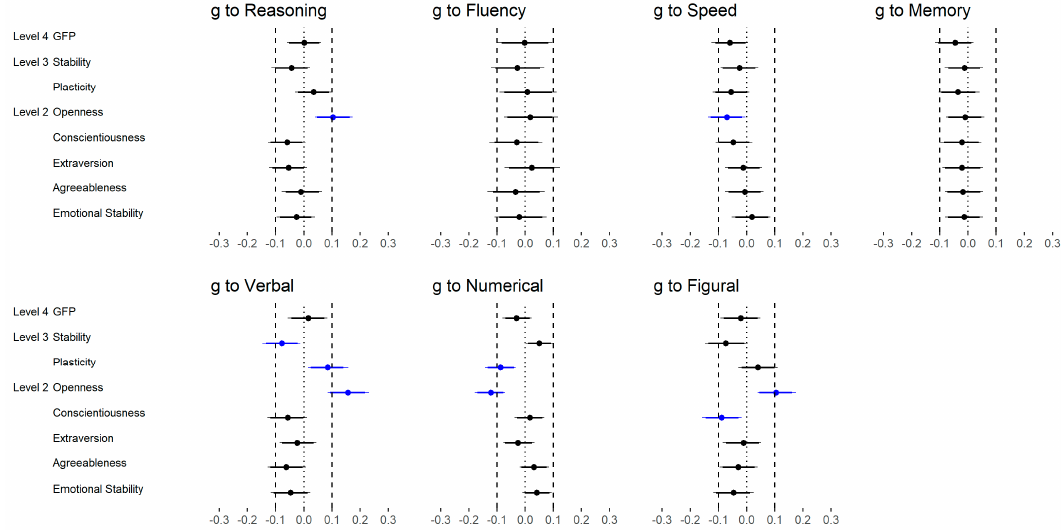
Figure 13. Study 2: Evaluation of the Brunswik Symmetry principle with regard to intelligence. Differences in correlations between the g -factor (high level) and specific abilities (medium level). Blue lines indicate substantially different correlations based on an equivalence testing approach.